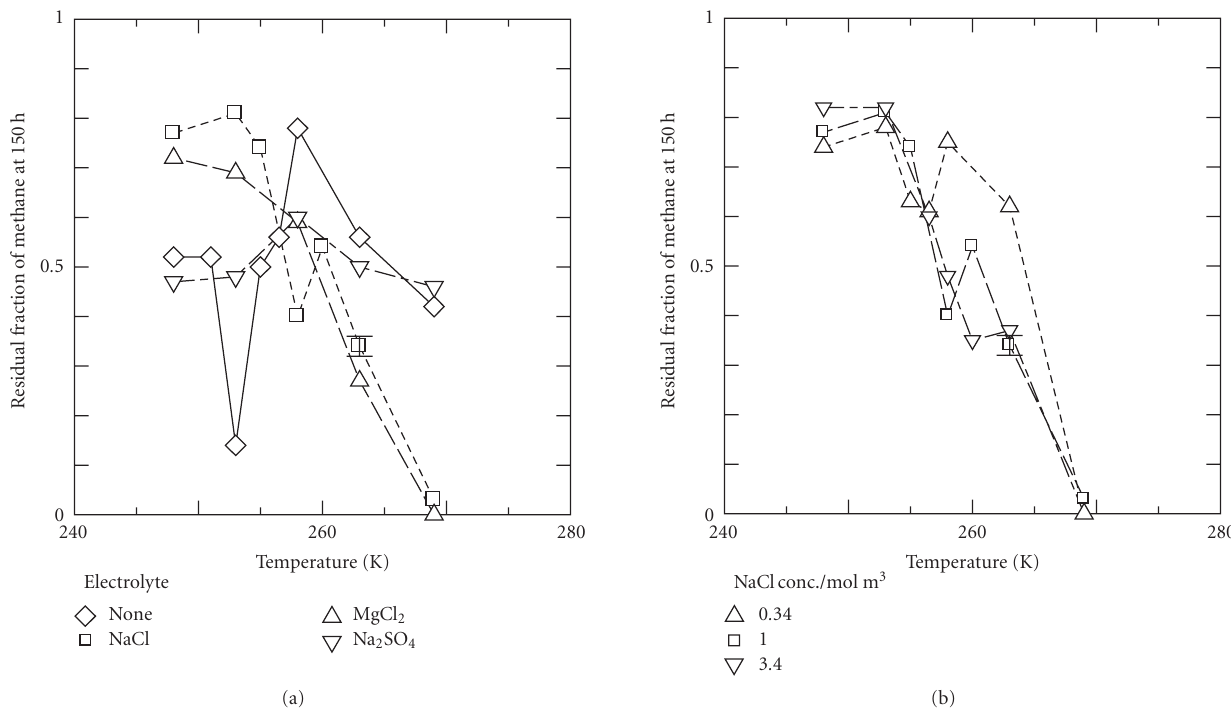
Figure 3: Residual fraction of methane in hydrate samples after an isothermal hold for 150 hours. (a) Samples prepared from pure water, 1.0mol/m 3 aqueous sodium chloride, 0.50 mol/m 3 aqueous magnesium chloride, or 0.50 mol/m 3 aqueous sodium sulfate. (b) Samples prepared from sodium chloride solutions of various